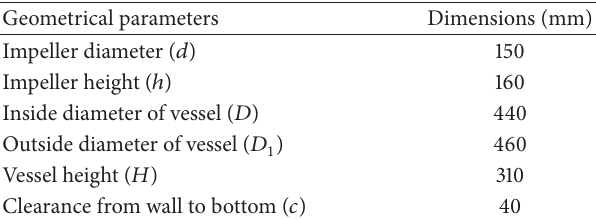
Table 1: Geometrical parameters of experimental